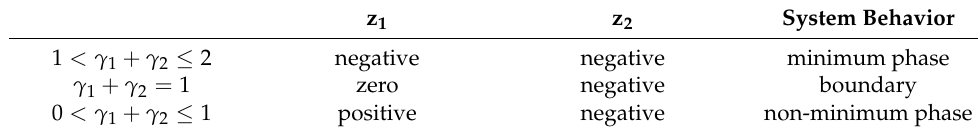
Table 2. Location of zeros on the linearized system as a function of the flow ratios γ 1 and γ 2 . z 1 z 2 System Behavior 1 < γ 1 + γ 2 ≤ 2 negative negative minimum phase γ 1 + γ 2 = 1